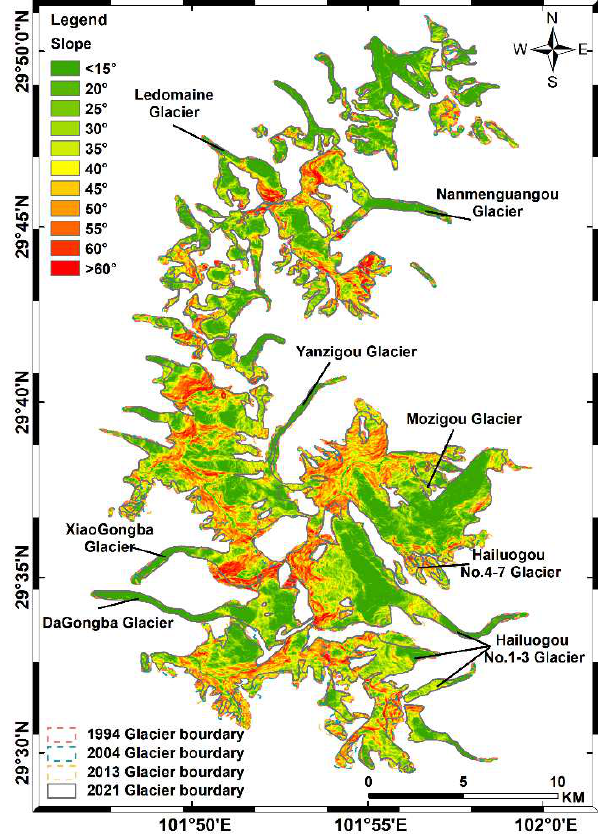
Figure 7. Glaciers distribution at different slope gradients in 1994, 2004, 2013, and 2021. Table 6. The area of glaciers in different slope aspects (unit: km 2